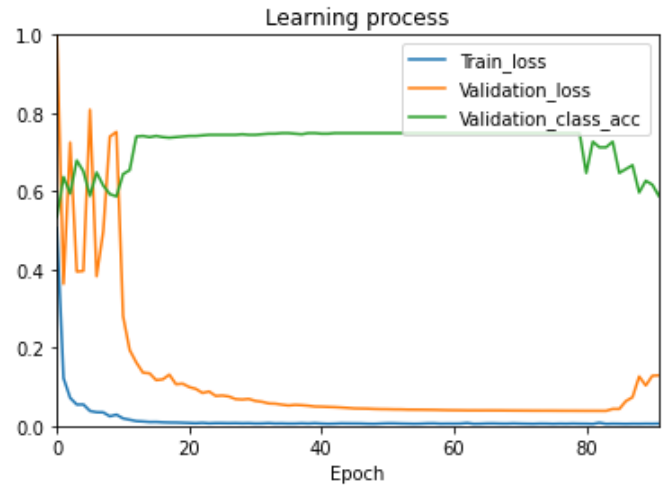
Figure 8. Result of the learning process per epoch.